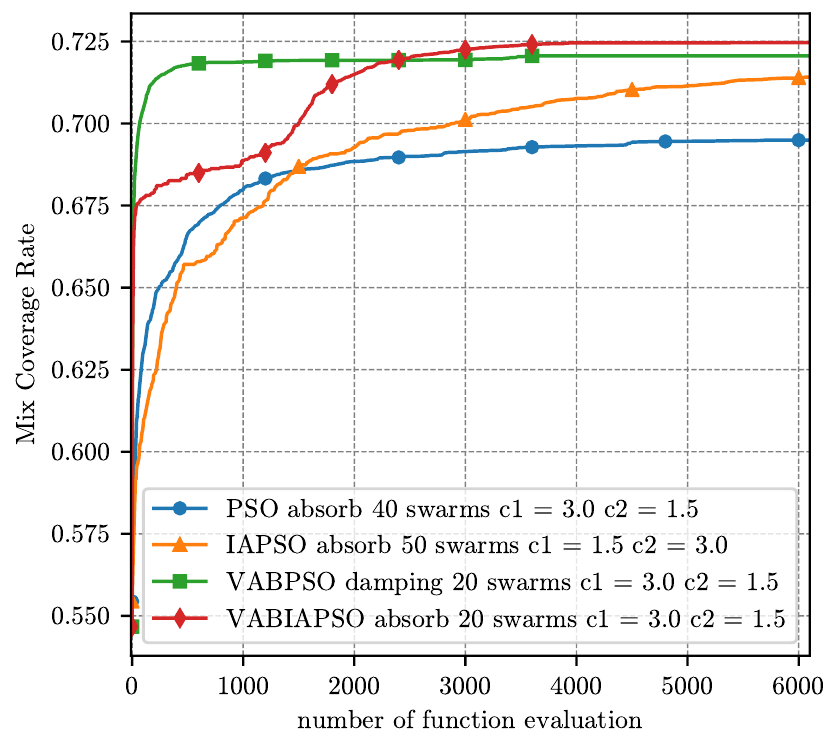
Figure 12. Performance comparison of four algorithms under the optimal parameters of the real scene. The statistics of different coverage of sampling points of the four algorithms are shown in Figure 14. Blue represents the number of sampling points covered by multiple sensor nodes, green represents single coverage, and red represents not covered. Both the IAPSO and the VABPSO algorithms achieve higher coverage than the standard PSO algorithms by reducing the number of sampling points covered by multiple sensors. The VABIAPSO algorithm further reduces the proportion of multiple coverage and realizes the coverages of more sampling points at the same